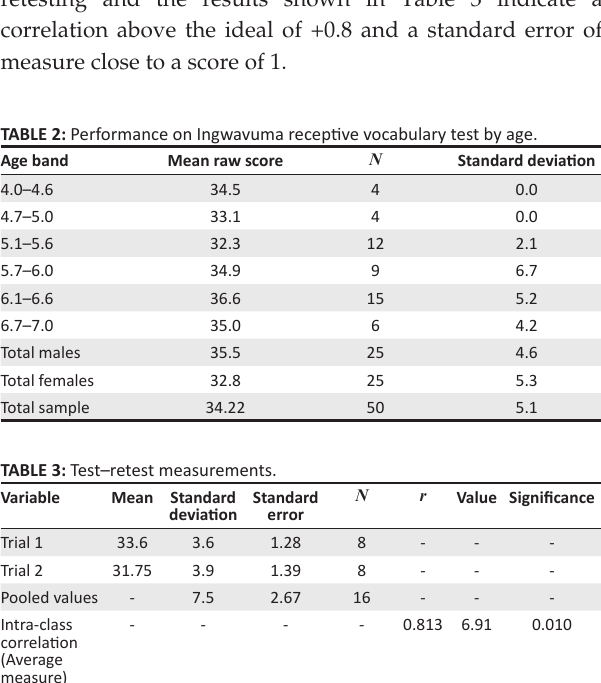
FIGURE 3: Test performance summary: Ingwavuma receptive vocabulary test, mean scores and distribution ( N =